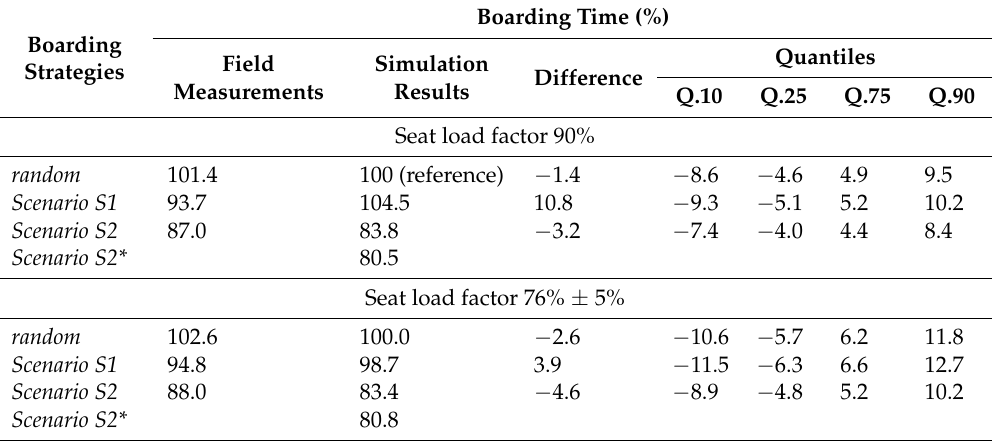
Table 3. Comparison of boarding progress using data from airline